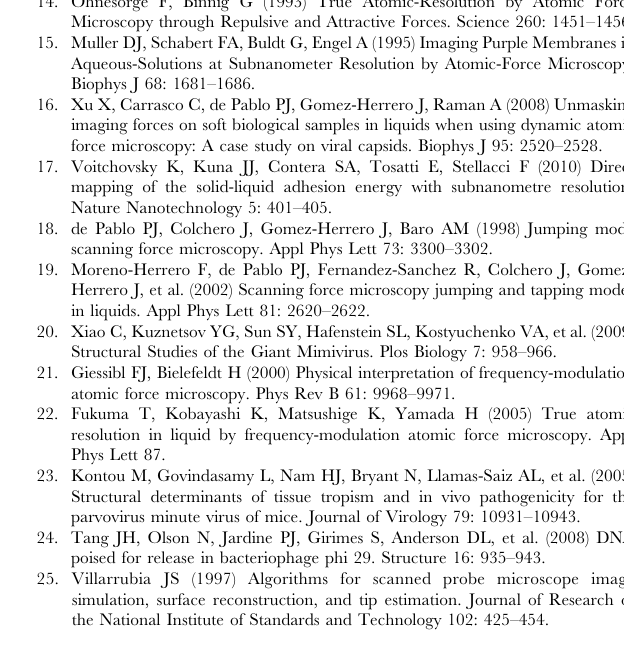
Figure S1 w 29 topographies obtained with high stiffness cantilevers (nominal stiffness 40 N/m). The dimension of the virus particles can be seen in the lines profiles. Figure S2 True atomic resolution of a mica surface immersed in a physiological buffer. The cantilever used to acquired the image has a stiffness as low as 0.6 N/m. Oscillation amplitude 0.7 nm, scan speed 600 nm/s, frequency shift 93 Hz. Figure S3 Feedback scheme for